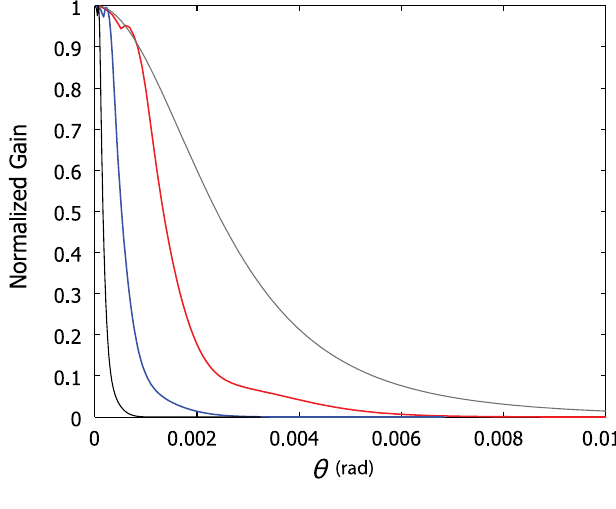
FIG. 3. Angular dependence of microbunching gain for